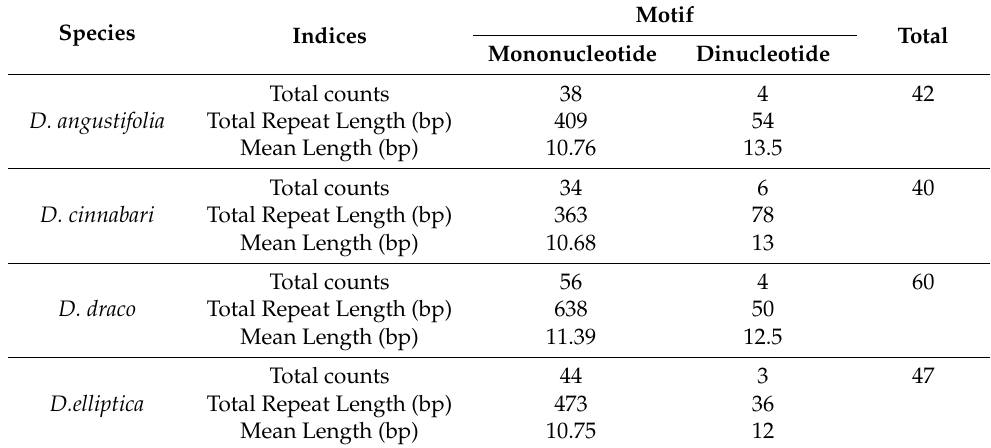
Table 3. Characteristics of SSRs present in the four Dracaena chloroplast genomes.